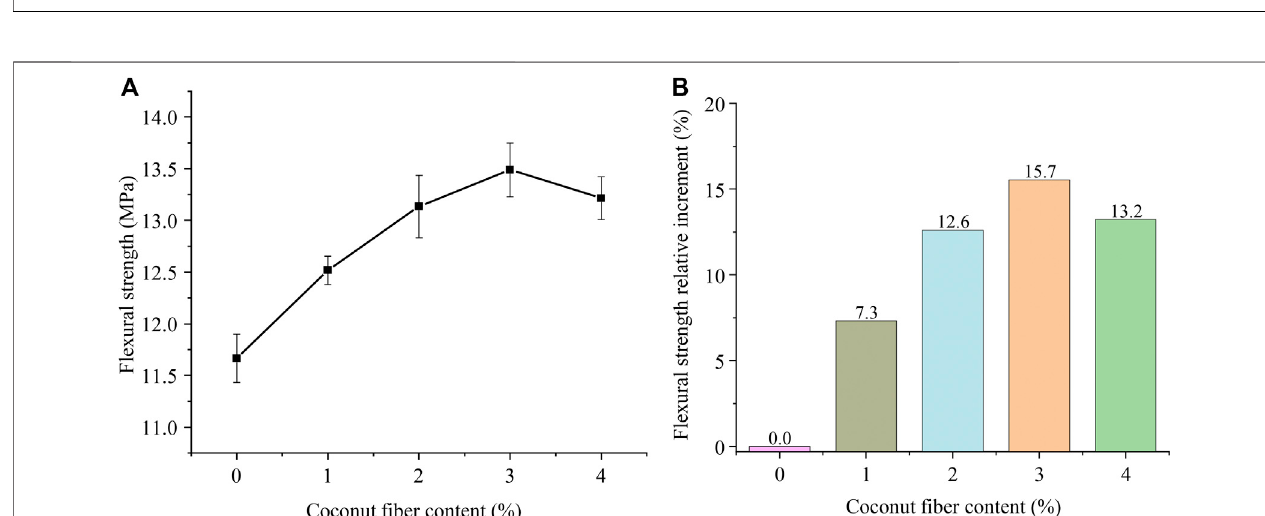
FIGURE 5 | Fracture surface of specimens (A) F1; (B) F2; (C) F3; (D) F4; (E) F5.